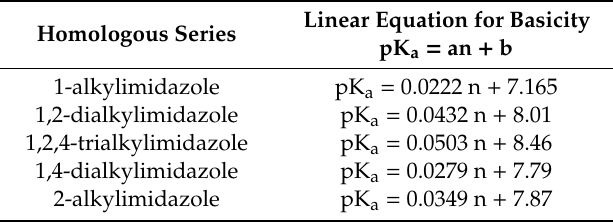
Table 1. Changes in the basicity of alkylimidazoles depending on the position and number of alkyl groups according to [54], in aqueous solutions at 25 °C, ionic strength 0.5 mol/dm 3 (KNO 3 ).